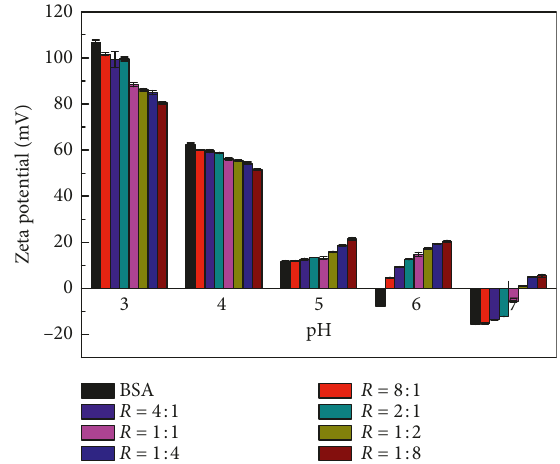
Figure 5: Zeta potential (mV) of emulsions (5% v/v oil, pH 3.0–7.0) stabilized by BSA (0.15%, w/v) and BSA-WSC mixtures with different biopolymer ratios ( R � BSA: WSC) in acetate buffer (0.1 mol/L) at 25 °